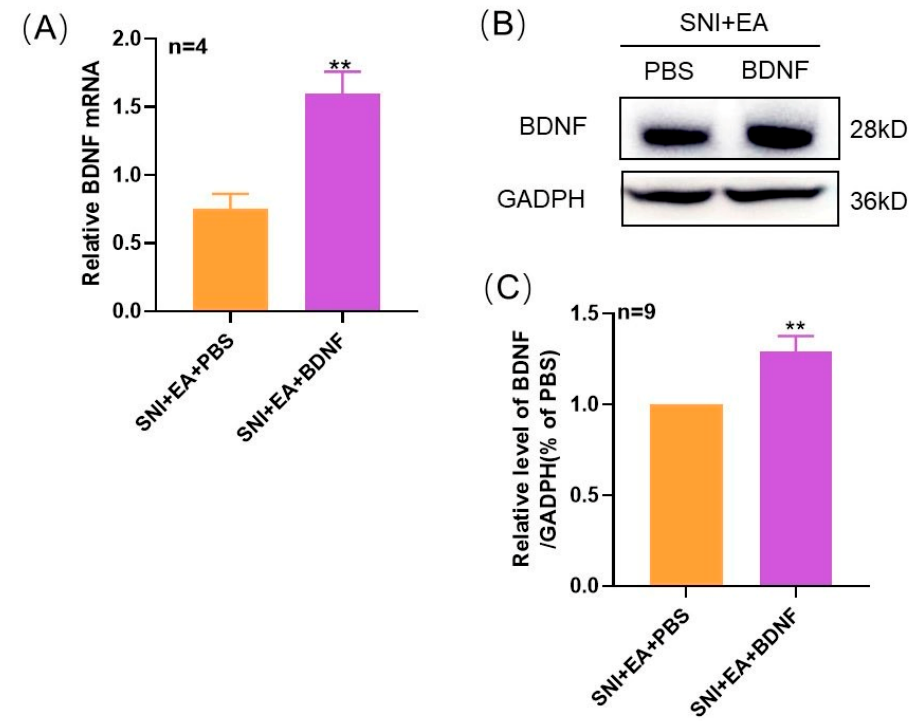
Figure 3. Effect of exogenous BDNF on spinal BDNF mRNA and protein expression induced by 2